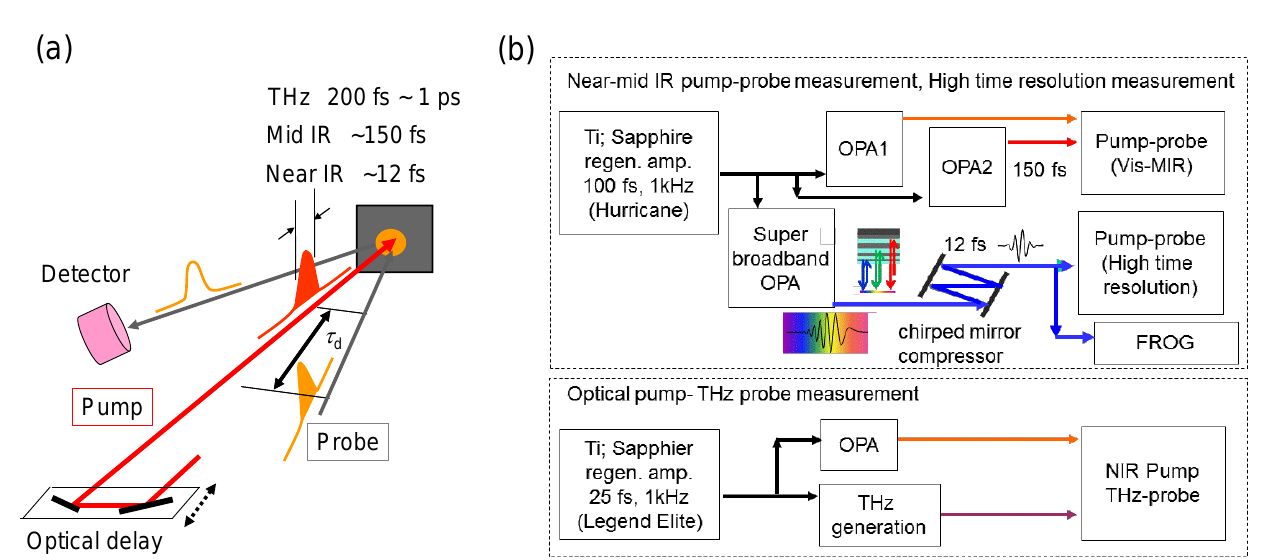
Figure 7a,c respectively shows the polarized reflectivity spectra of α-(ET) θ-(ET) RbZn(SCN) for the electric field of light perpendicular to the molecular stack [ a -axis in 2 4 α-(ET) I and c -axis in θ-(ET) RbZn(SCN) ]. A reflection band at less than 0.8 eV was assigned to the 2 2 4 CT transition between the ET molecules [41–43]. Reflectivity ( R ) spectra for temperatures T > T T < T are shown respectively as dashed and solid curves. Open circles in Figure 7b,d shows the co transient reflectivity change  R / R spectra at 20